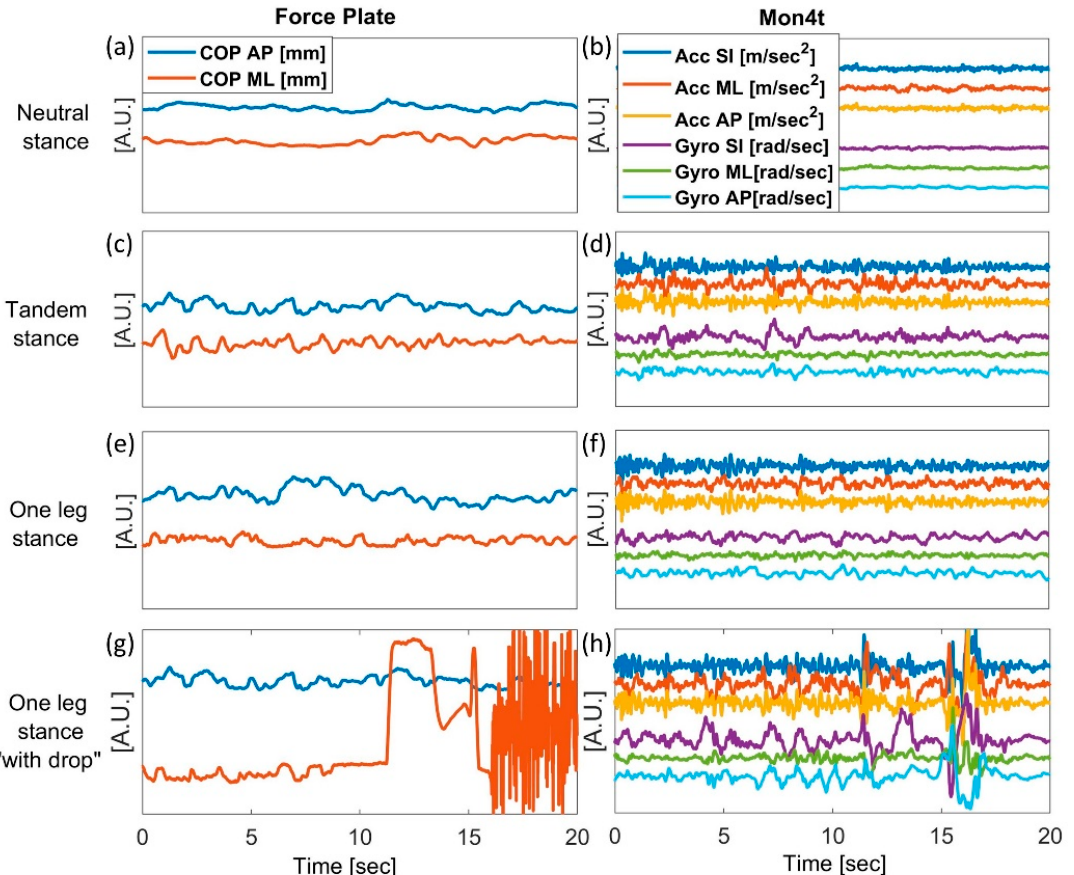
Figure 6. Force plate and Mon4t raw data across different static stances. The left column represents the normalized center of pressure coordination in the AP and ML directions. The right column represents the smartphone’s sensors: three axial accelerometers and gyroscopes, provided by the Mon4t app.